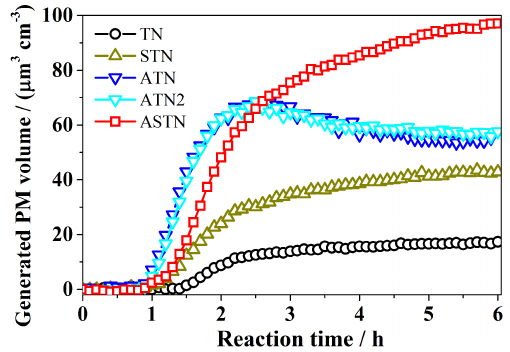
Figure 1. Secondary aerosol formation in photooxidation of toluene / NO x in the presence or absence of NH 3 and/or SO 2 . The letter codes for the experiments indicate the introduced pollutants, i.e. A for ammonia, S for sulfur dioxide, T for toluene, and N for nitrogen dioxide. Experimental details are listed in Table